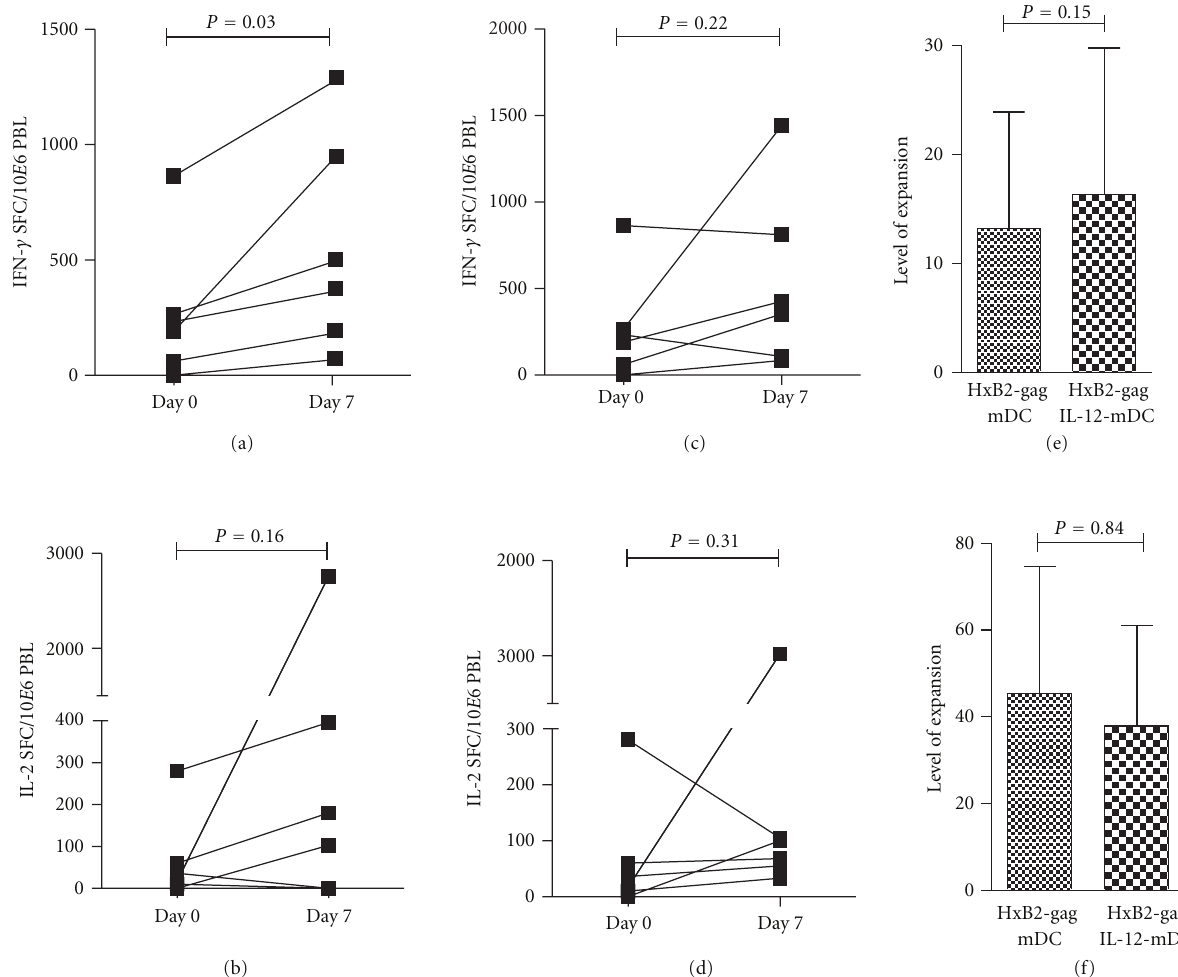
Figure 2: E ff ect of coelectroporation of DCs with IL-12p70 mRNA on HIV gag -specific T cell responses after 1 week of stimulation. Freshly thawed PBLs were directly incubated in ELISpot with HIV gag -derived peptides (Day 0) or PBLs were stimulated for one week with autologous HIV gag mRNA-electroporated DCs. For this, DCs were either matured with a simplified cytokine cocktail (TNF- α and PGE 2 ) (a) and (b) or DCs were matured with this simplified cytokine cocktail in combination with IL-12p70 mRNA electroporation (c) and (d). Thereafter, cocultured PBLs were restimulated with HIV gag -derived peptides and evaluated in ELISpot for detection of antigen-specific IFN- γ (a), (c) and (e) or IL-2 (b), (d), and (f) secretion. Results are shown as mean of triplicate analyses for each donor displaying a positive response ( n = 6), as defined in the Materials and Methods